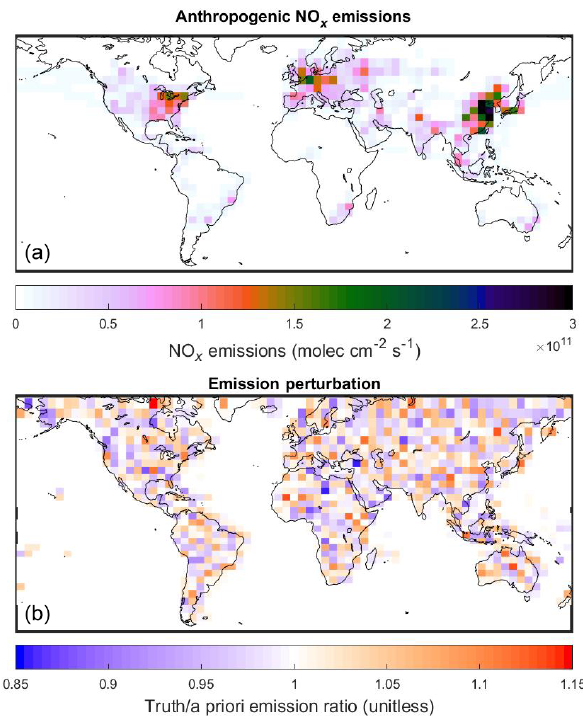
Figure 2. (a) Anthropogenic NO x emissions for July 2010 used in GEOS-Chem. (b) Ratio of true emissions used to create Obs 5 synthetic observations to a priori NO x